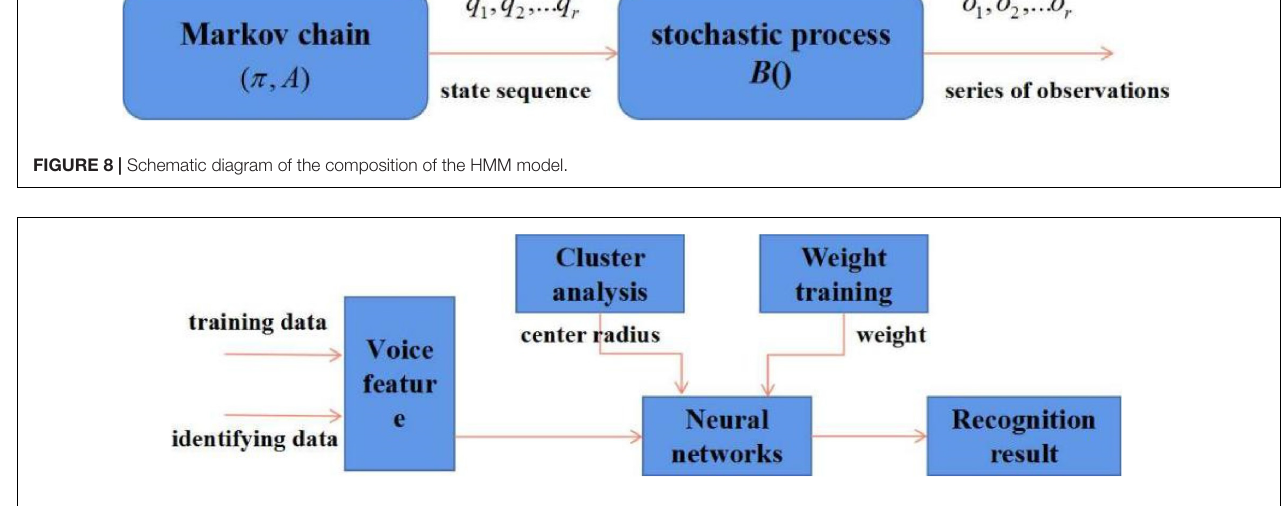
FIGURE 9 | Mixed model neural network training process.